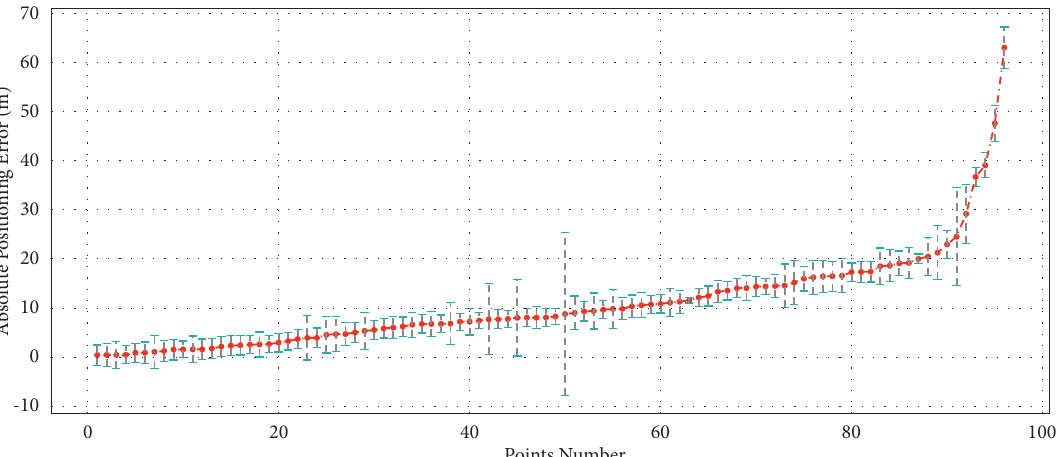
Figure 8: Absolute positioning error at each verification point arranged from small to large. The error bars represent the standard deviation of